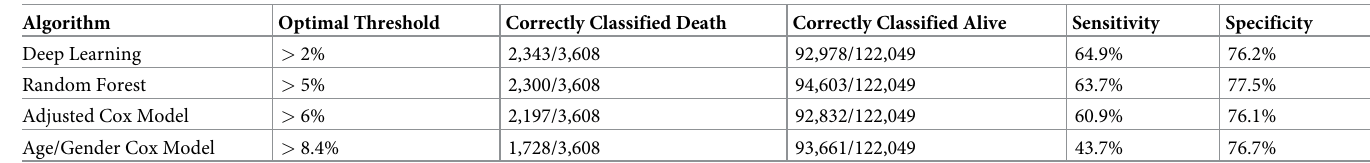
Table 4. Binary classification accuracy comparing each algorithm for predicting “high” risk of mortality in the test cohort (n = 125,657).